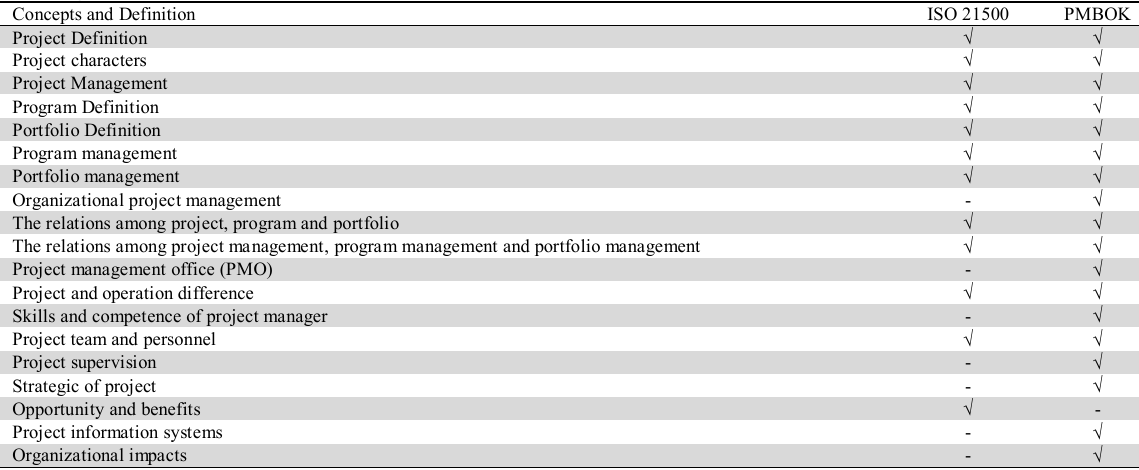
Findings of section 1